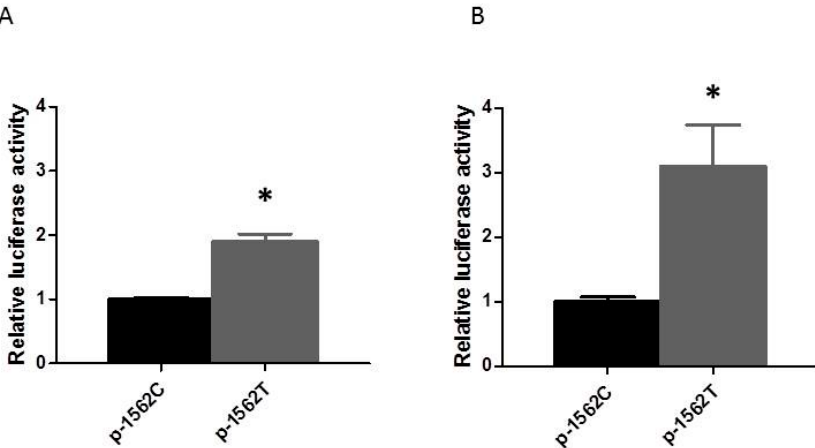
Figure 3. Effect of the rs3918242 on the MMP9 transcriptional activity in HL-1 cells with and without rapid pacing. ( A ) HL-1 cells were transfected with plasmids containing rs3918242 C or T allele in the MMP9 promoter for 6 h. The luciferase activity was assayed as described in Methods; ( B ) HL-1 cells were transfected with plasmids containing rs3918242 C or T allele in the MMP9 promoter for 24 h and subsequently received tachypacing (4 Hz) for 6 h. Each value (mean ± SE, n = 4) is expressed as a fold change of luciferase activity relative to the control condition. * represents p < 0.05.